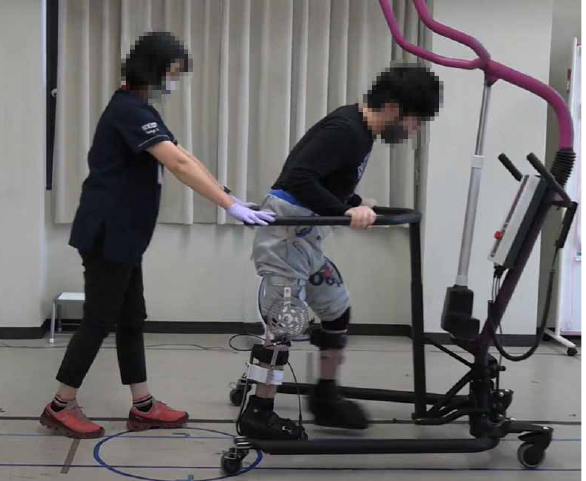
Figure 9. Individual with CP performing the experiment while wearing the device. Faces have been blurred for